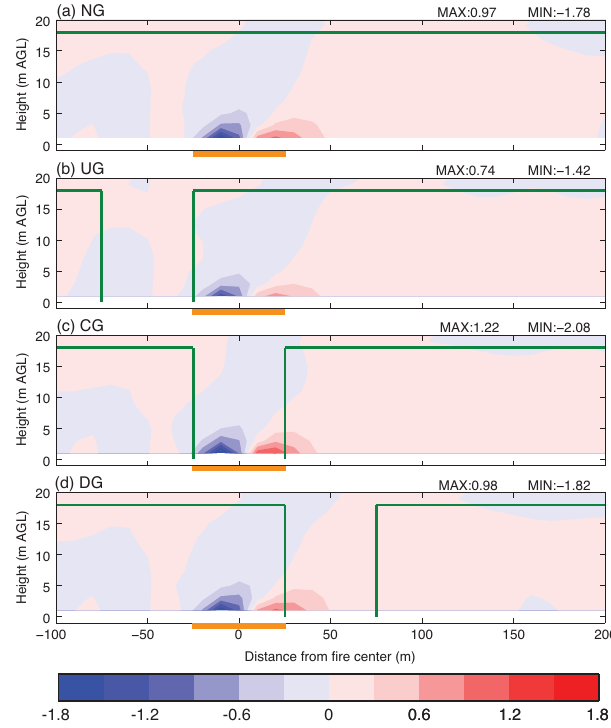
Figure 7. As in Fig. 2 but for the horizontal gradient of the hori- zontal turbulent heat flux (Ks − 1 ); shading interval: 0.3Ks − 1 . Note that the y axis only extends up to